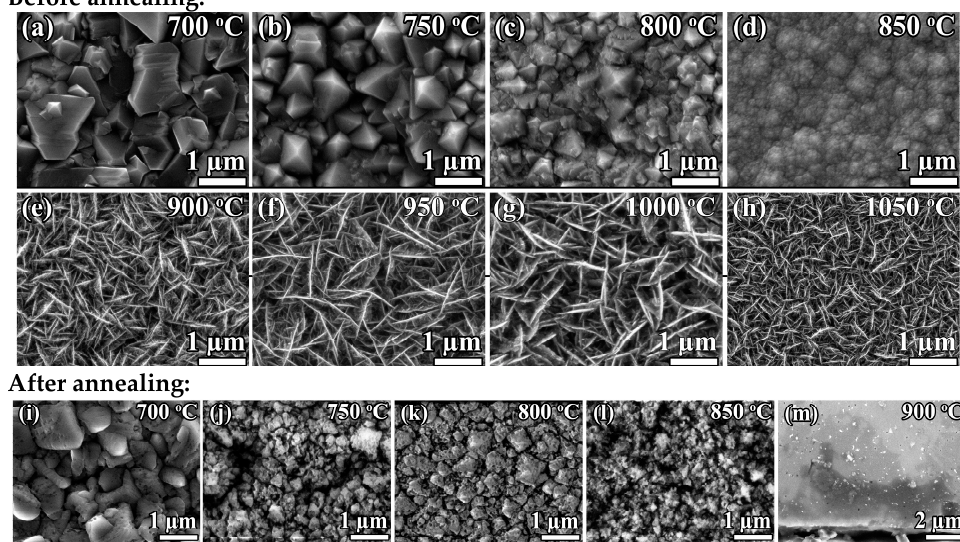
Figure 1. SEM images of polycrystalline diamond films synthesized at fixed CH 4 to total flow con- centration 𝜈 𝑐 = 40% and different substrate temperatures before ( a – h ) and after ( i – m ) air annealing. At the fixed (40%) methane concentration, an increase in temperature from 700 to 750 °C firstly leads to a change in the faceting of diamond crystallites, which is evidence of the effect of CVD growth conditions on the texturing of PCD film. With a further increase in T (cid:2929) up to 850 °C, the film morphology transforms to nanocrystalline (NCD) diamond. In addition, at higher temperatures, only the deposition of graphite sheets occurs. Evidence of the more defective structure of PCD films grown at 𝜈 (cid:3030) = 40% is their weakness to the